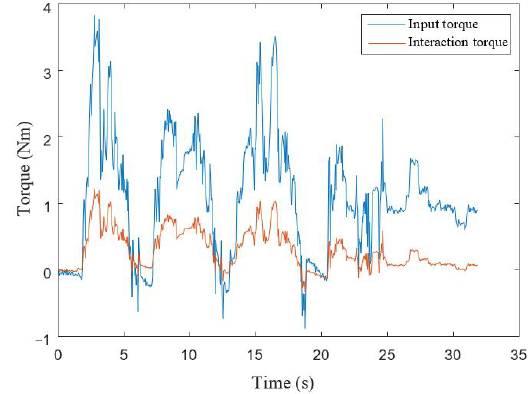
Figure 11. Human – machine interaction torque. Figure 11. Human–machine interaction